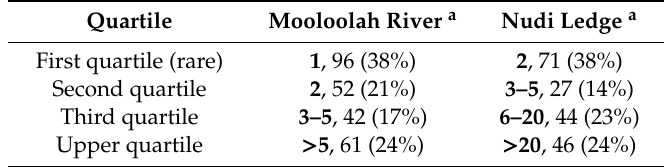
Table 2. Cut-o ff values (in quartiles—increments of 25%) for measures of temporal rarity, including number (percent) of species falling into each category. Percentages rounded to nearest whole number. Quartile Mooloolah River a Nudi Ledge a First quartile (rare) 1 , 96 (38%) Second quartile 2 , 52 (21%)